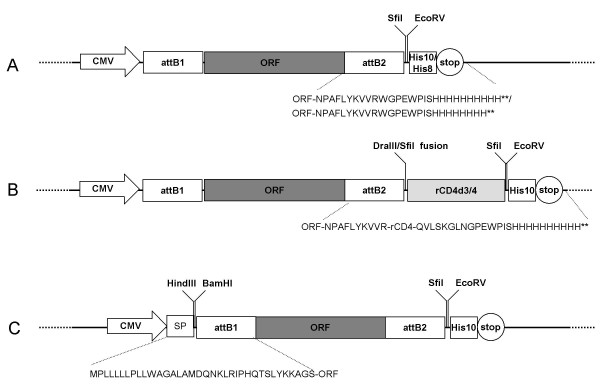
Expression vector constructs used in transient transfections and purified protein controls. (A) Schematic representation of His10 and His 8 tagged expression vectors with amino acid sequence of attB2 site and His tag shown. (B) Schematic representation of rCD4(d3+4)-His10 tagged expression vector used to express mouse test proteins, amino acid sequence from attB2 site to stop codon (rCD4 sequence has been represented as rCD4) is shown. (C) Schematic representation of His10 tagged expression vector containing signal peptide (SP) at N terminus with amino acid sequence of SP and attB1 site shown. CMV = CMV promoter element, ORF = open reading frame, attB1 = attB1 recombination site, attB2 = attB2 recombination site, rCD4 = rat CD4 domains 3 and 4 tag, His10 = decahistidine tag, His8 = octahistidine tag, stop = stop codon and SP = CD33 signal peptide sequence.